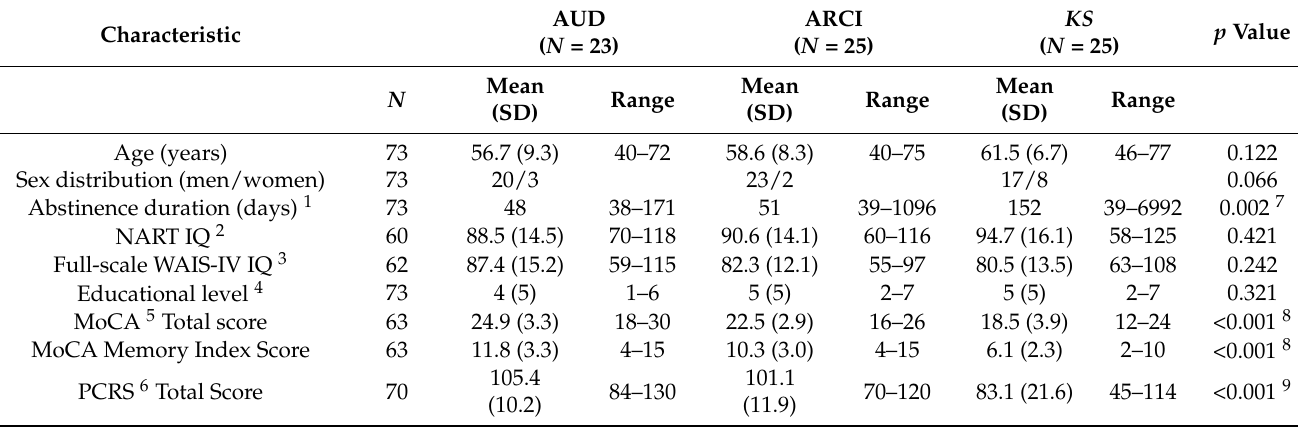
Table 1. Group characteristics of patients with alcohol use disorder (AUD), alcohol-related cognitive impairments (ARCI) and Korsakoff’s syndrome